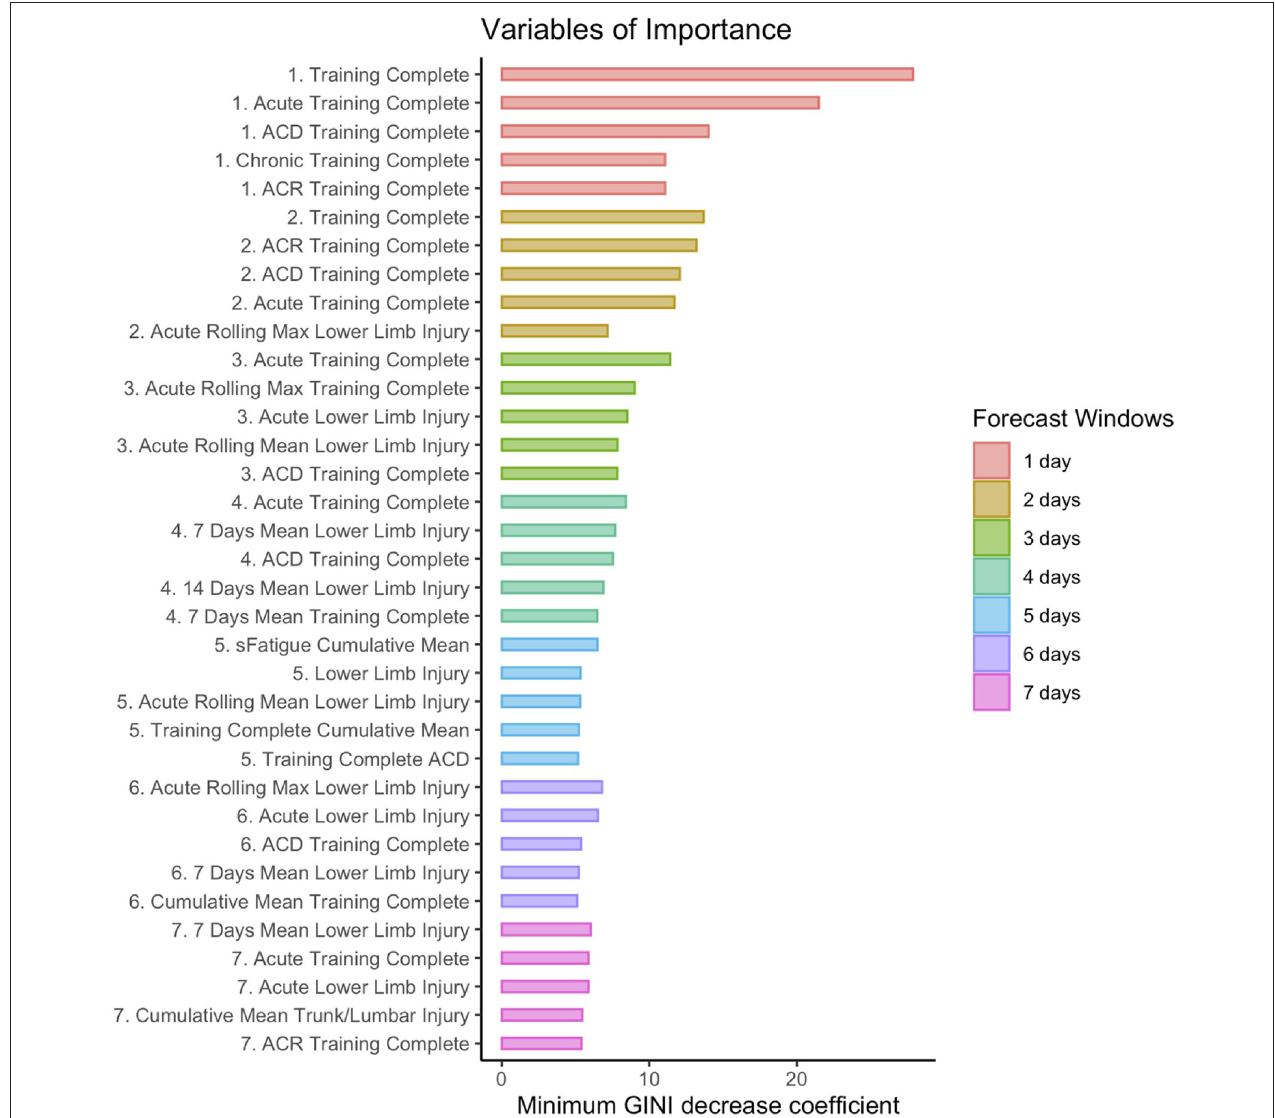
FIGURE 4 | The 5 most important variables for each forecasting window (1 to 7 days) of the ALL forecasting models. The selected variables of importance were the ones with the highest minimum GINI decrease coefficient. The variables are numbered and colored according to their corresponding forecasting time period. ACD, Acute Chronic difference. ACR, Acute to Chronic